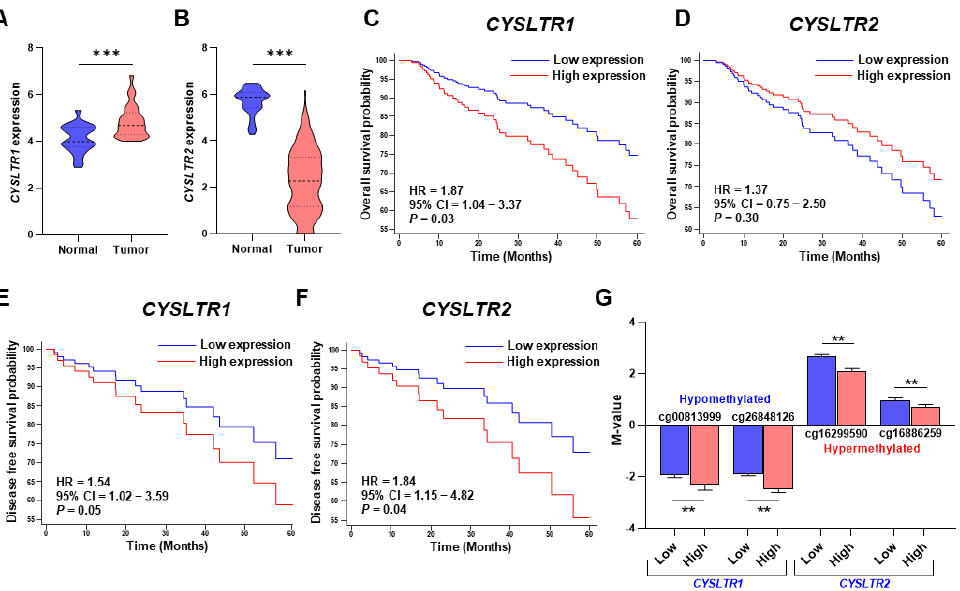
Figure 1. Violin plot of the relative expression and Kaplan – Meier survival plot of the CYSLTR1 and CYSLTR2 genes in the TCGA-COADREAD cohort. Relative expression of CYSLTR1 ( A ) and CYSLTR2 ( B ) between normal and tumor samples. Five-year Kaplan – Meier overall survival plots for CYSLTR1 ( C ) and CYSLTR2 ( D ). Five-year Kaplan – Meier disease-free survival plots for CYSLTR1 ( E ) and CYSLTR2 ( F ). ( G ) Correlation of M-values for CpG probes with CYSLTR1 (cg00813999, cg26848126) and CYSLTR2 (cg16299590, cg16886259) gene expression in tumor samples. ** p < 0.01; *** p < 0.001.